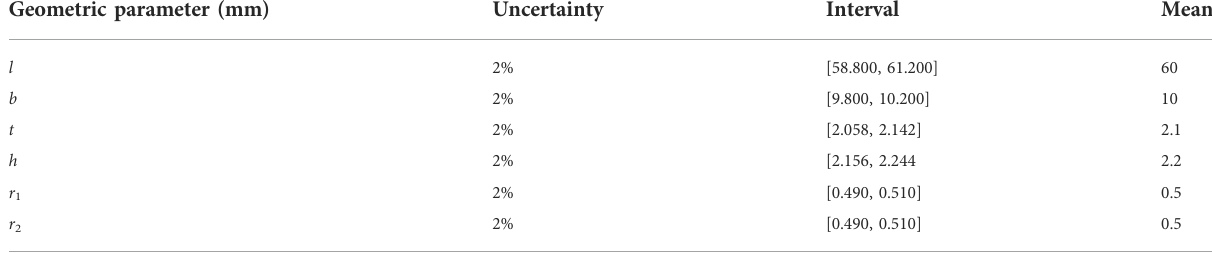
TABLE 3 The geometric interval parameters with uncertainties. Geometric parameter